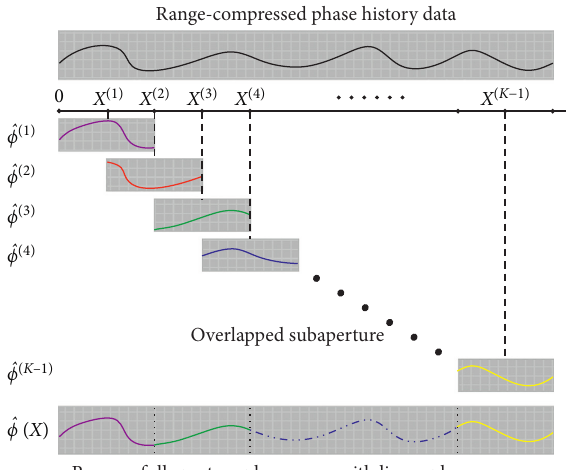
Figure 4: Full-aperture phase error combination.